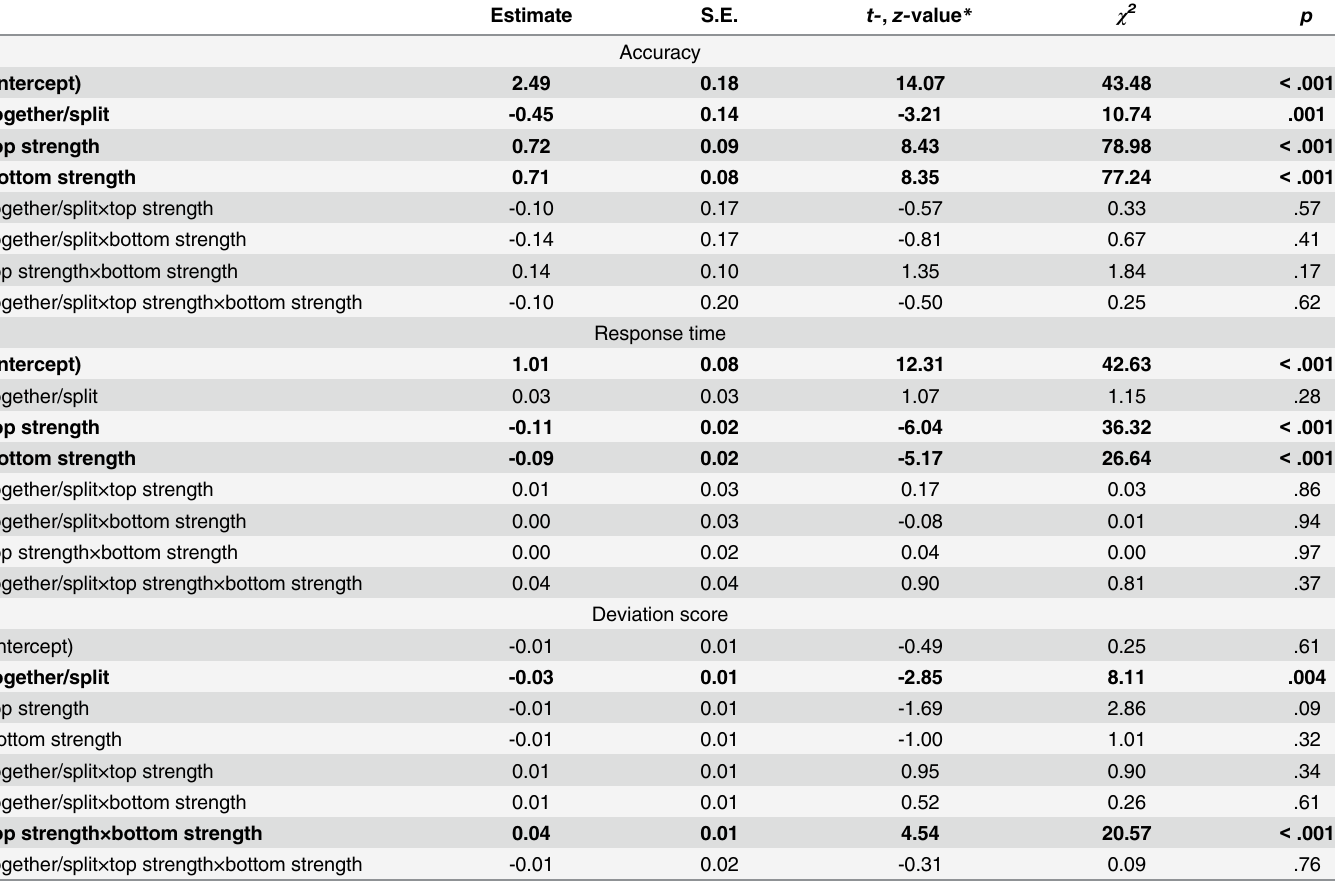
Fig 2. Data and model predictions for accuracy (top), response time (middle), and deviation scores (bottom) for weak (w), medium (m), and strong (s) half faces and averaged within the weak-weak (ww), weak-medium (wm), weak-strong (ws), medium-medium (mm), medium-strong (ms), strong-strong (ss), and weak-opposite medium (wom) together and split whole-face conditions. Error bars are between-subject standard errors. The far right error bars and circles in the top two panels are the standard errors and model predictions for the half faces. doi:10.1371/journal.pone.0138481.g002 order. The mean accuracies for both together and split wom trials were greater than chance, t (18) = 5.07, p < .001, d = 1.16 and t (18) = 4.11, p < .001, d = 0.94, and less than the mean accu- racy for medium half faces, t (18) = 8.27, p < .001, d = -1.90 and t (18) = 7.07, p < .001, d = -1.62, confirming that the weak half faces were taken as evidence for the appropriate category. As expected, the opposite faces yielded the lowest accuracy, suggesting that participants per- ceived top and bottom halves as supporting opposite responses. These trials were included only as a manipulation check and will not be discussed further. Accuracy increased as the strength of the top- and bottom-faces increased. Accuracy on split faces was significantly lower than accuracy on together faces (.87 vs. .91). A more direct test of differences in dilution across con- ditions is provided below. Table 1. Results of the linear mixed-effects models for accuracy, response time, and deviation score. Note . The χ 2 and p values were determined by comparison with the full model. All χ 2 df = 1. Bold = p < .05. Estimate S.E. t- , z- value * χ 2 p Accuracy